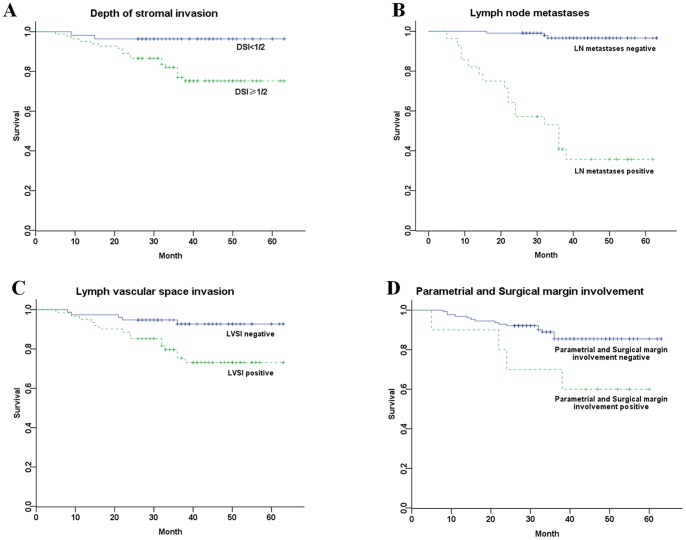
Progression-free survival of young patients with different pathological risk factors.(A) PFS of young patients stratified by DSI (log-rank test P = 0.005). (B) PFS of young patients stratified by LN metastases (log-rank test P = 0.000). (C) PFS of young patients stratified by LVSI (log-rank test P = 0.000). (D) PFS of young patients stratified by parametrial and surgical margin involvement (log-rank test P = 0.006).